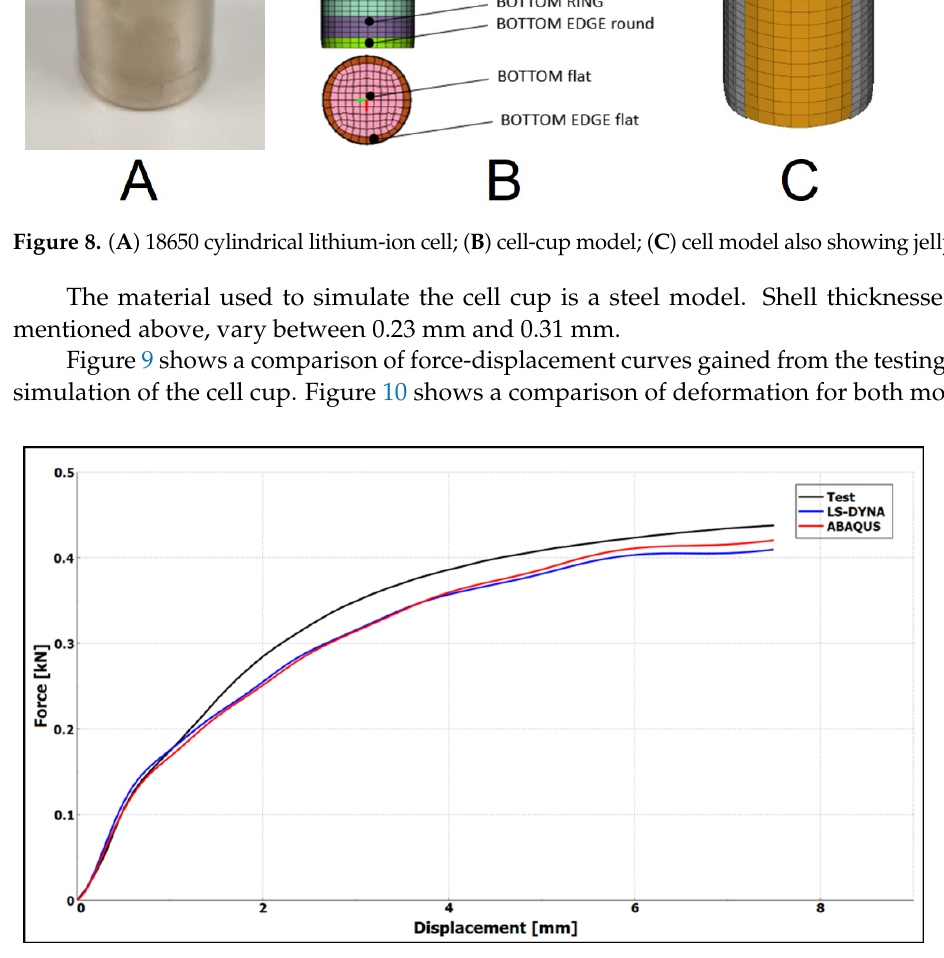
Figure 9. Force-displacement curves of the cell cup’s load-case radial crush impactor.